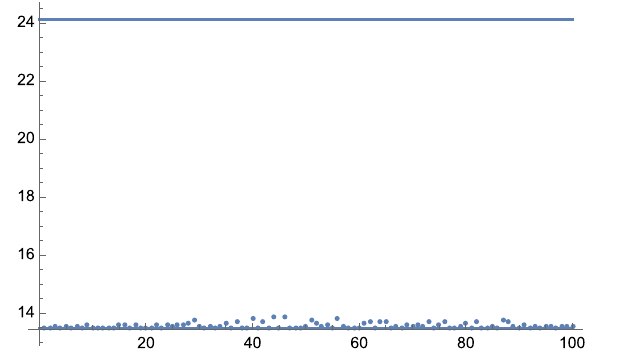
Fig. 3 The variances V [ F ] of Example 1 computed for 100 independent executions with 4 Newton–Raphson iterations for the Kullback–Leibler divergence exploiting 50 samples in each iteration. The horizontal lines correspond to the optimal and the equal sampling budget variances,